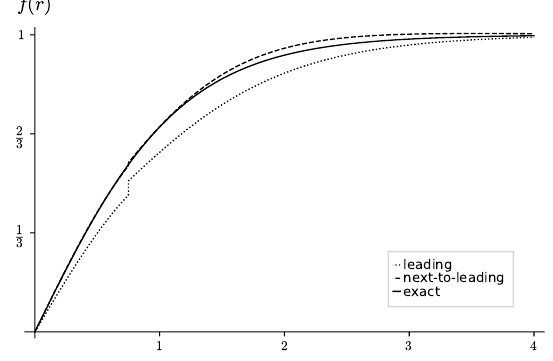
Figure 5 . The numerical solution of the exact n = 1 critical vortex equations for the scalar field f ( r ) (solid line), the leading order (dotted line), and the next-to-leading order (dashed line) solutions with the core and boundary layer matched at r = 3 / 4